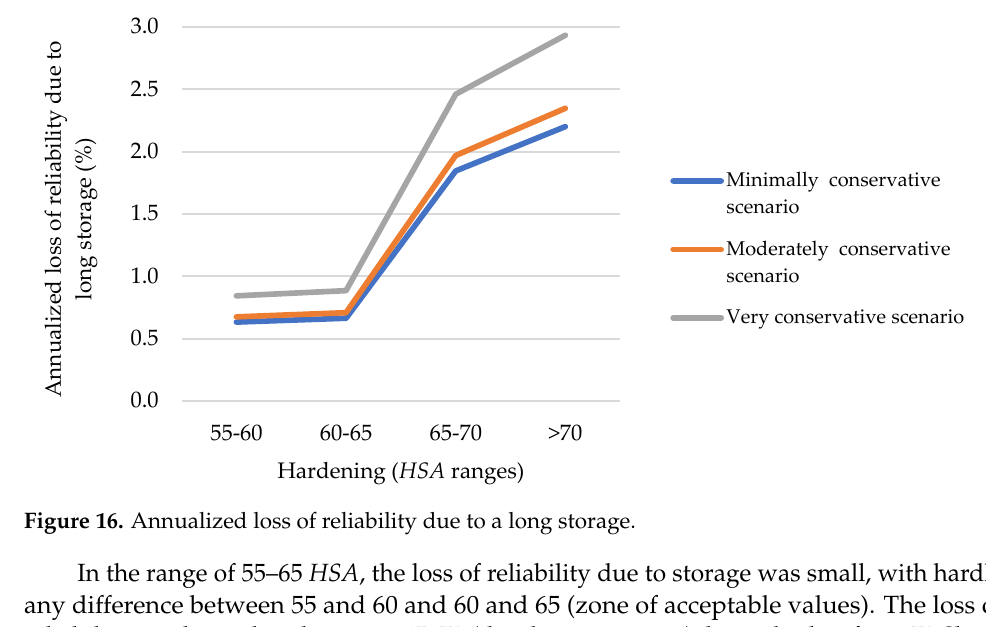
Figure 15. Probability of failure according to the accumulated operating time. POF ( t ) represented in Figure 15 indicates how the accumulated in-service time affects the risk of failure (losing reliability). During the three first years of operation the increase of POF is practically insignificant. Nevertheless, from this point, and especially, from 5 years of operation, the POF increased from 10% to 20% at approximately 6 years (for new and stored). From 6 years, the behavior of curves (for new and stored) are more different. In the case of stored ones, there is a linear progression up to reaching a POF equal to 0.78 at 10 years; while, in the case of the new ones, the POF is practically 100% when they reach an accumulated in-service time equivalent to 10 years. Seen from another point of view, the annualized loss of reliability can be quantified as a function of the hardening (or the measured value of hardness). As the last compared supply was dated in 2018, three comparative scenarios were established (very conservative, 24 years; medium, 22.5 years; and minimally conservative, 18). Thus, Figure 16 provides the annualized loss of reliability considering the three scenarios of analysis; since the loss of reliability is considered, in this case, to be due to the storage (and, therefore, the comparison of the three scenarios needs to be more precise).